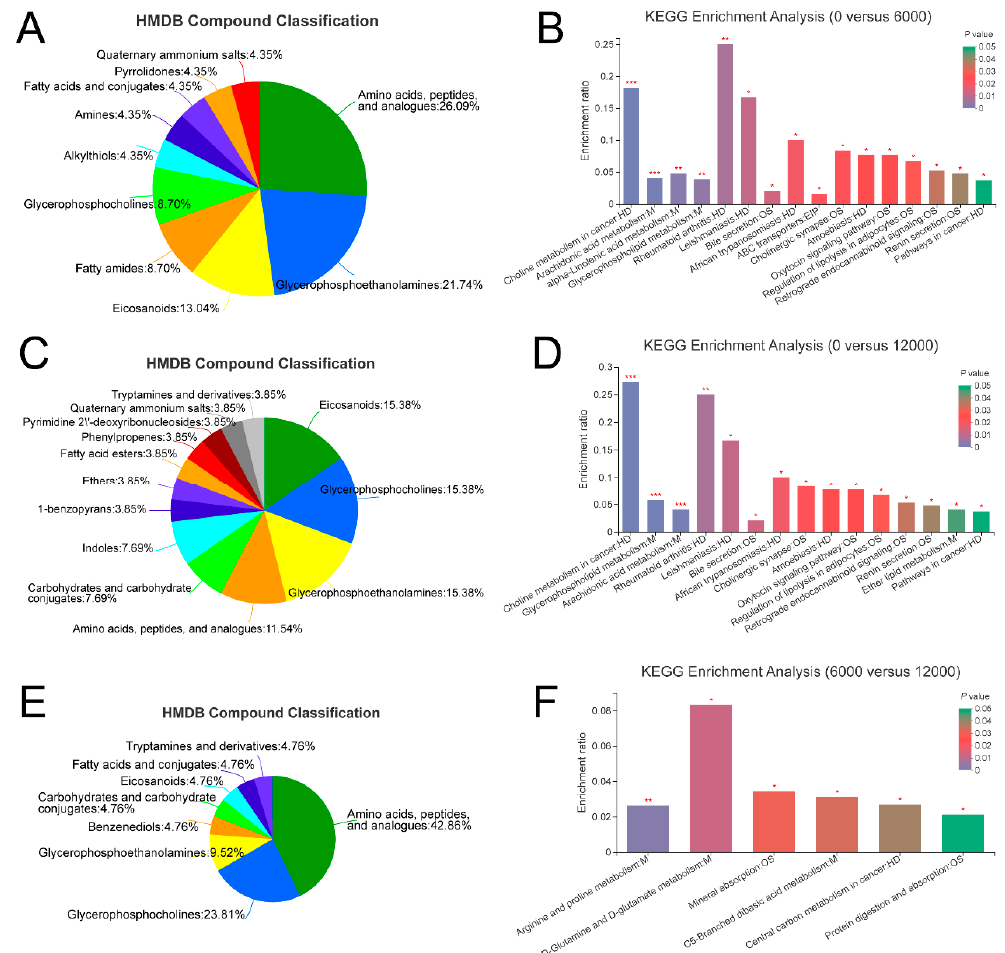
Figure 4. Classification of differential metabolites annotated to HMDB database in the three compared groups: ( A ) 0 versus 6000 mg/kg; ( C ) 0 versus 12,000 mg/kg; ( E ) 6000 versus 12,000 mg/kg. KEGG enrichment analysis based on differential metabolites in the three compared groups: ( B ) 0 versus 6000 mg/kg; ( D ) 0 versus 12,000 mg/kg; ( F ) 6000 versus 12,000 mg/kg. Levels of significance are defined as * ( p < 0.05), ** ( p < 0.01) and *** ( p < 0.001).